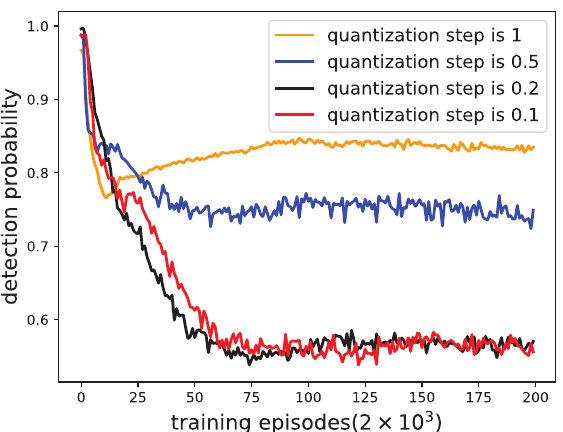
Figure 8. Detection probability curves of different quantization